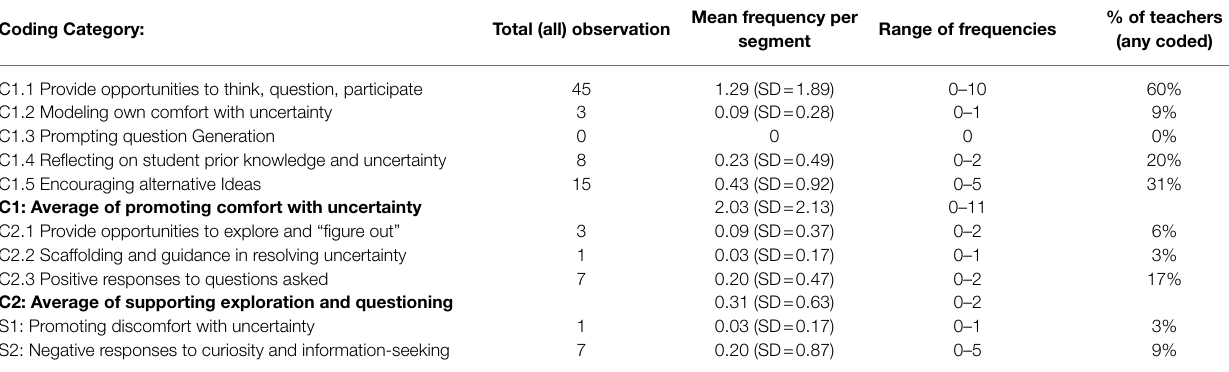
TABLE 2 | Observations of curiosity-promoting instruction across all lessons coded (two 10-min segments from each of 35 lessons). Coding Category: Total (all) observation